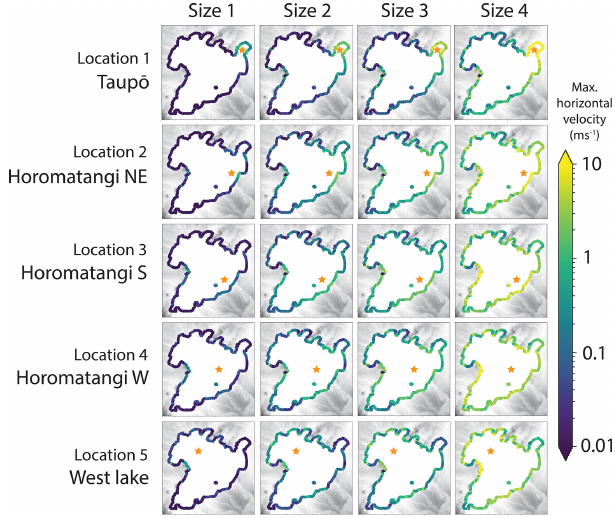
Figure 5. Scenario matrix illustrating maximum water horizontal velocity reached at all points along the lake foreshore, where sizes are detailed in Table 1 and locations in Table